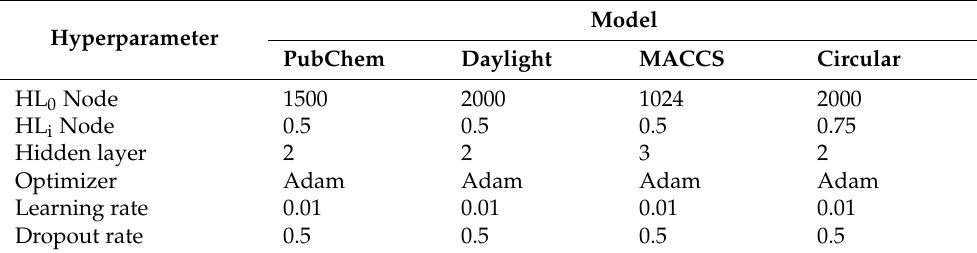
Table 2. Optimal hyperparameter for SAE-DNN model.